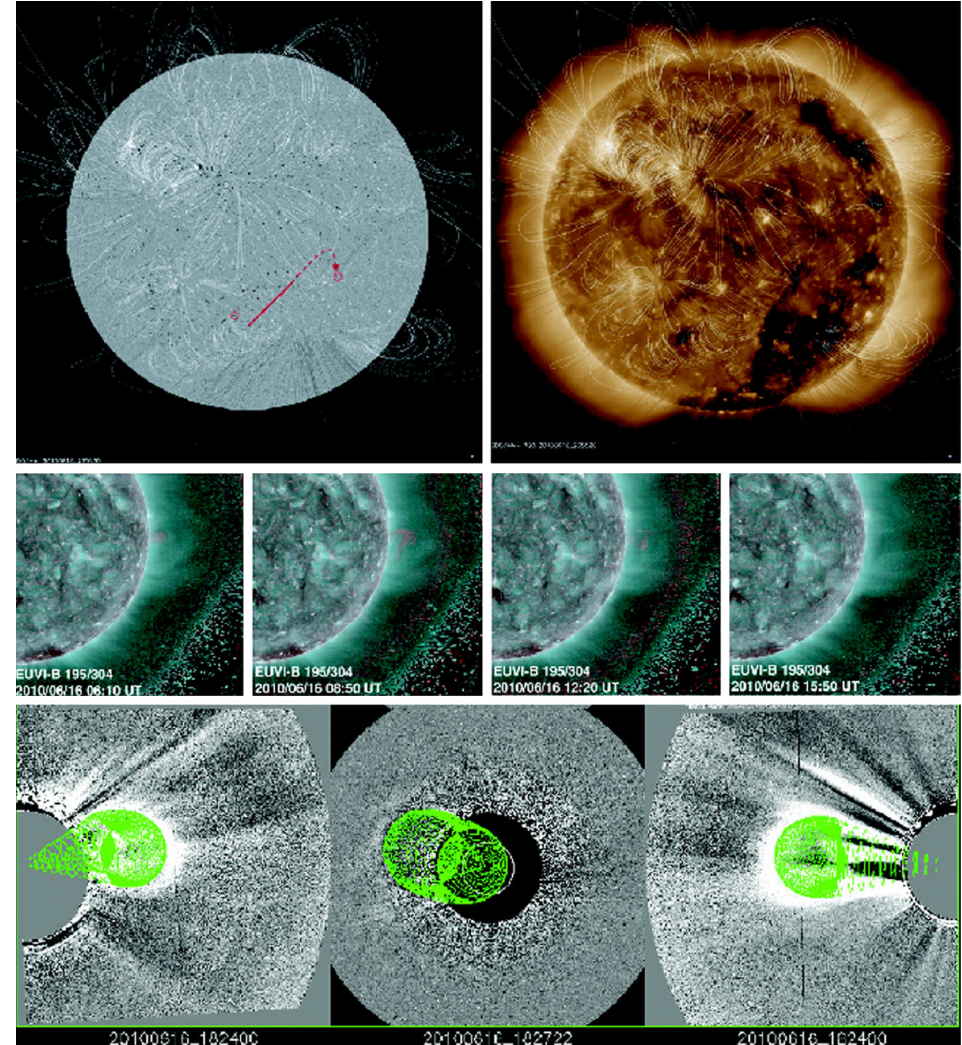
Figure 5. Solar observations of the source region and CME of 16 June 2010. Top left: the HMI synoptic magnetic field is shown with PFSS coronal extrapolation. The red line indicates the source of the CME red circles giving the foot points of the erupting flux rope. Top right: AIA 193 Å image of Sun. Middle row: STEREO EUVI-B images in 195 and 304 Å show a quiescent filament lifting off as the CME erupts. Bottom row: GCS model fitting to the CME event of 16 June 2010. The left, centre and right panels are simultaneous data from STEREO COR2-B, SOHO LASCO C2, and STEREO COR2-A, respectively. The images have been over plotted (green) with the GCS model represented by a grid of points on the surface of the model flux rope [85].